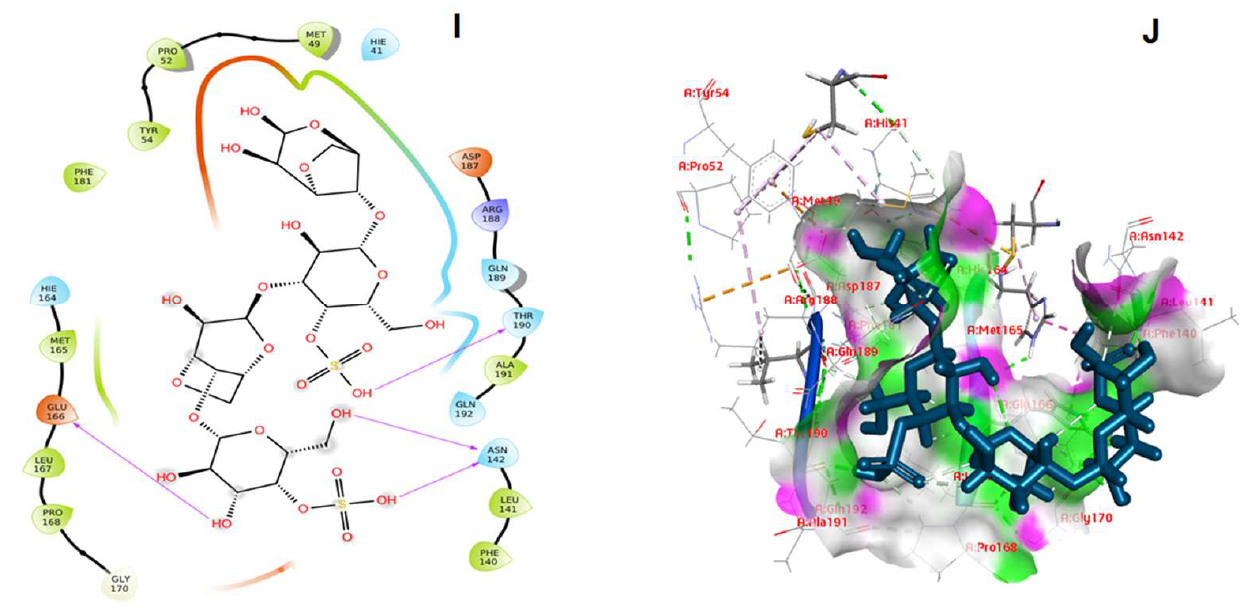
Figure 6. ( I , J ) Illustrations of the interaction between Kappa-Carrageenan and the target M pro protein of SARS-CoV-2.